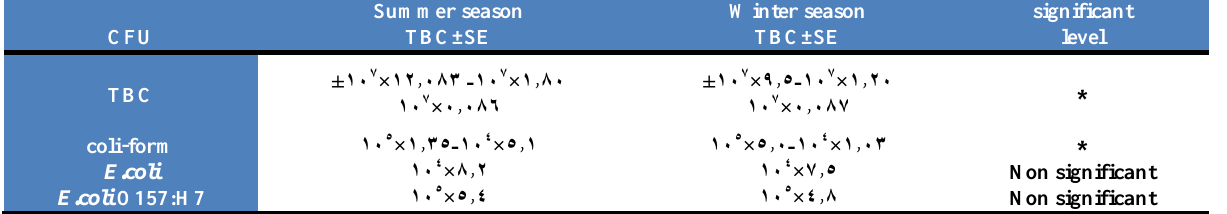
-SE = standard error. *Significant difference